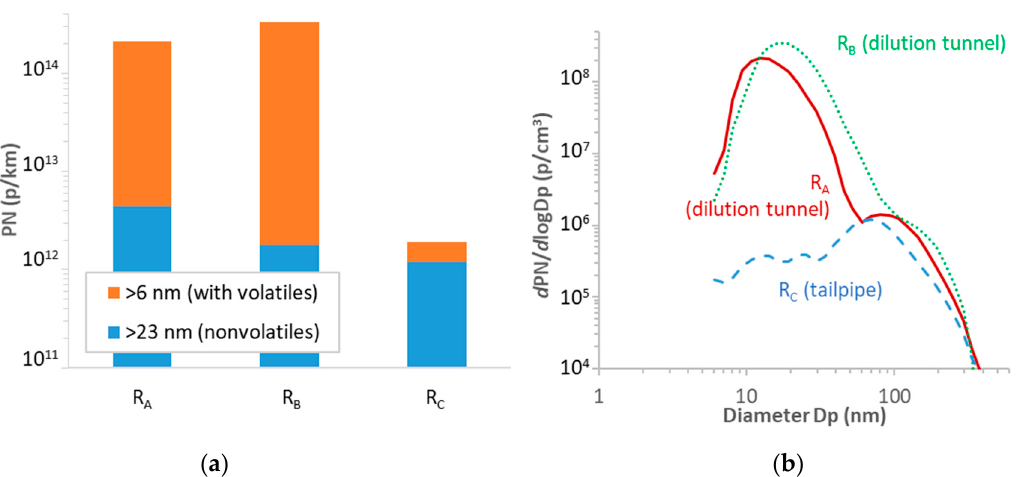
Figure 2. Particle number (PN) emissions during three regeneration events at 100 km/h (R A , R B and R C of Figure 1): ( a ) nonvolatile PN > 23 nm and total PN > 6 nm (i.e., including volatiles) and ( b ) typical size distributions of total PN during the three regeneration events. In one case the sampling was conducted from the tailpipe (R C ), while at the other two (R A , R B ) from the dilution tunnel; all three with cold dilution.